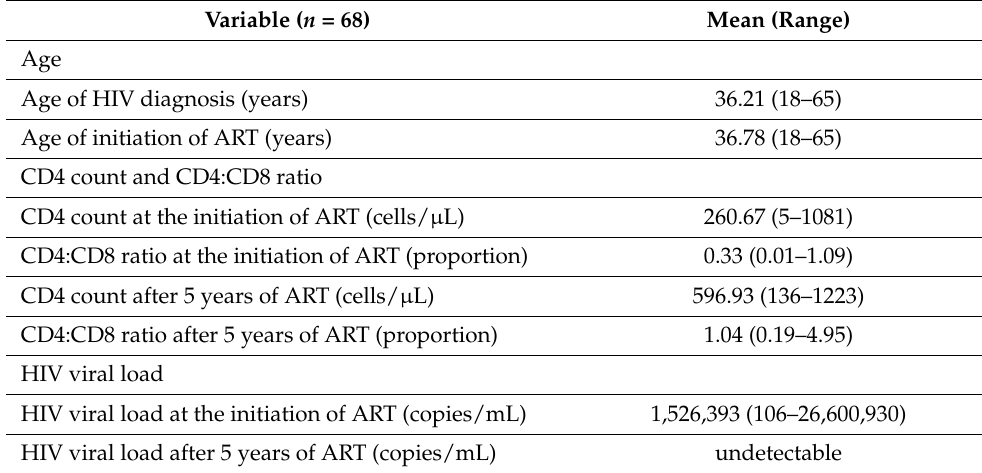
Table 1. Study group